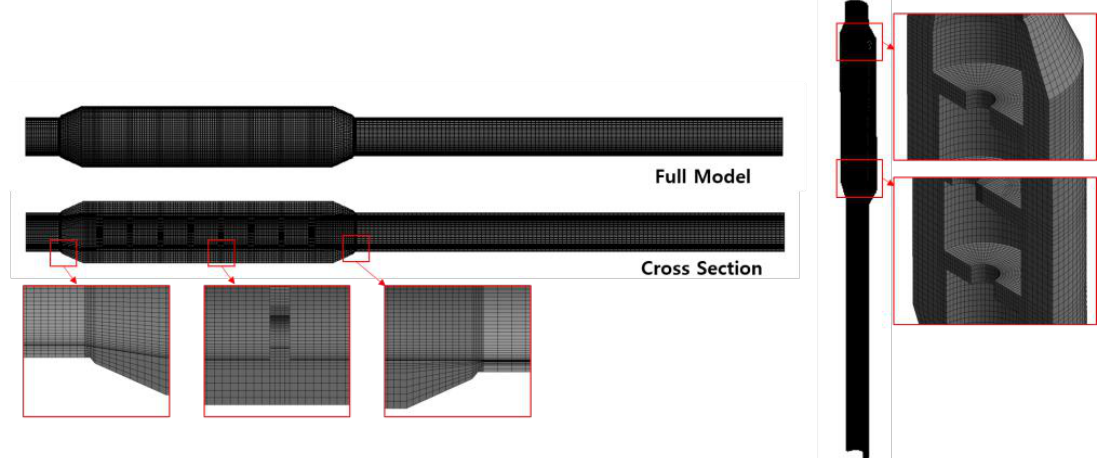
Figure 9. Grid system for the structural analysis of the eight-stage orifice.